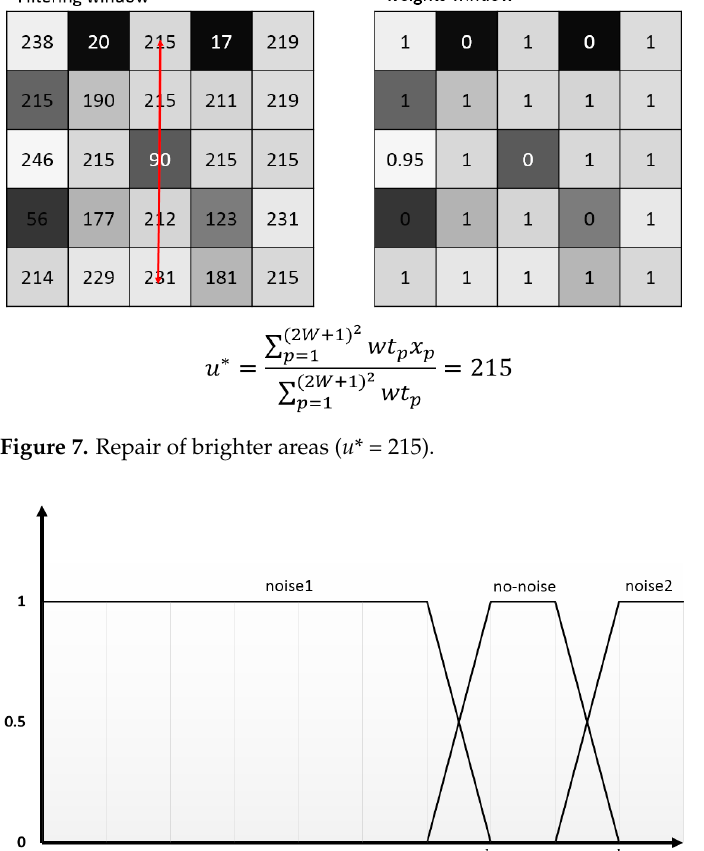
Figure 6. Pixel value of high noise restoration ( u * = 163).